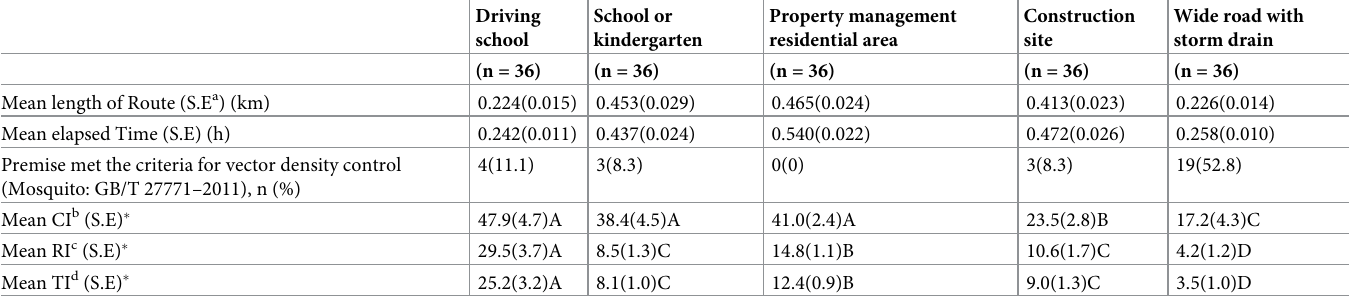
Table 1. Length and elapsed time of inspection and the number of premises that met the criteria for vector density control and larval indices of five types of premise in built-up areas of